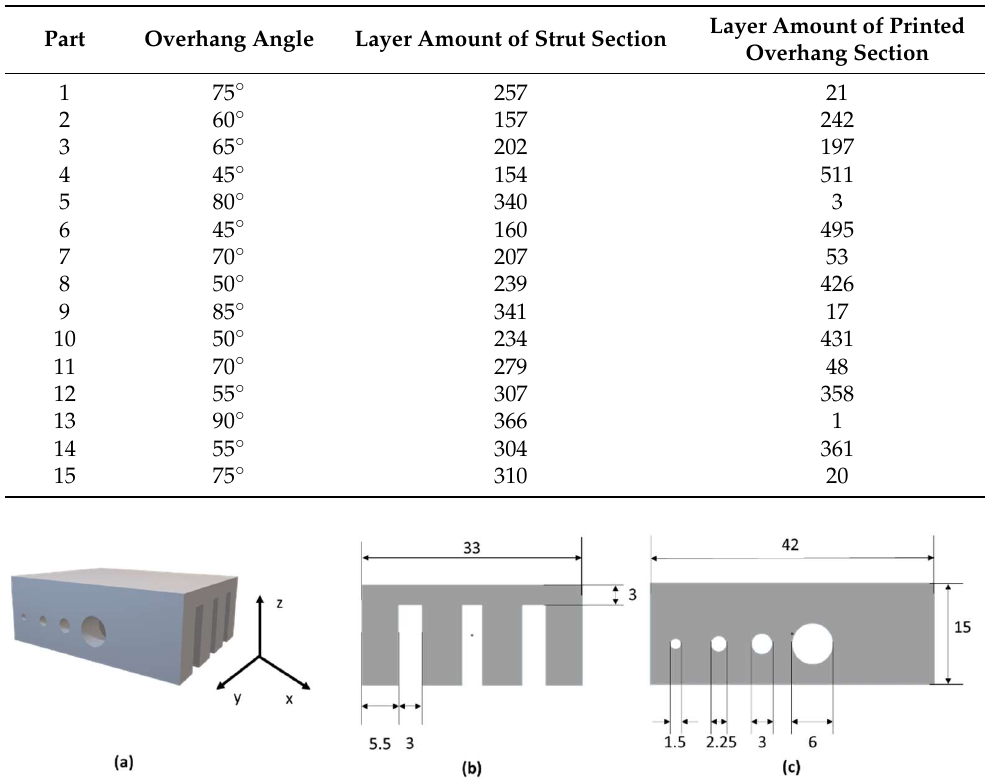
Table 3. Layer height of printed